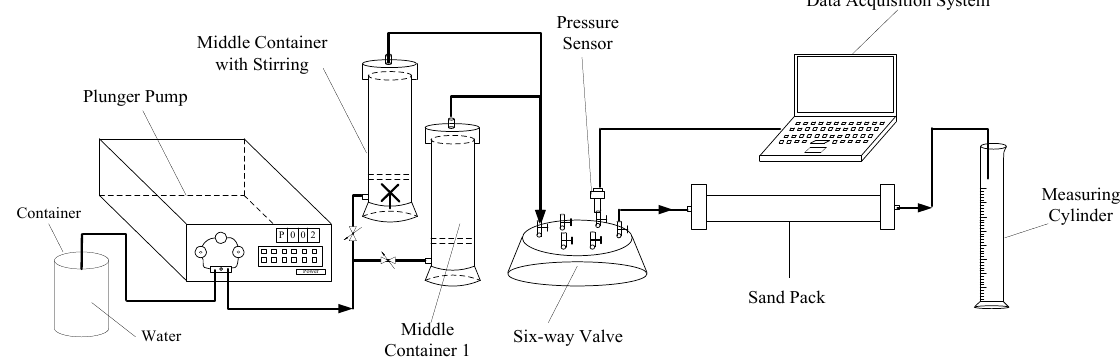
Figure 11. Comparison of blocking performances.